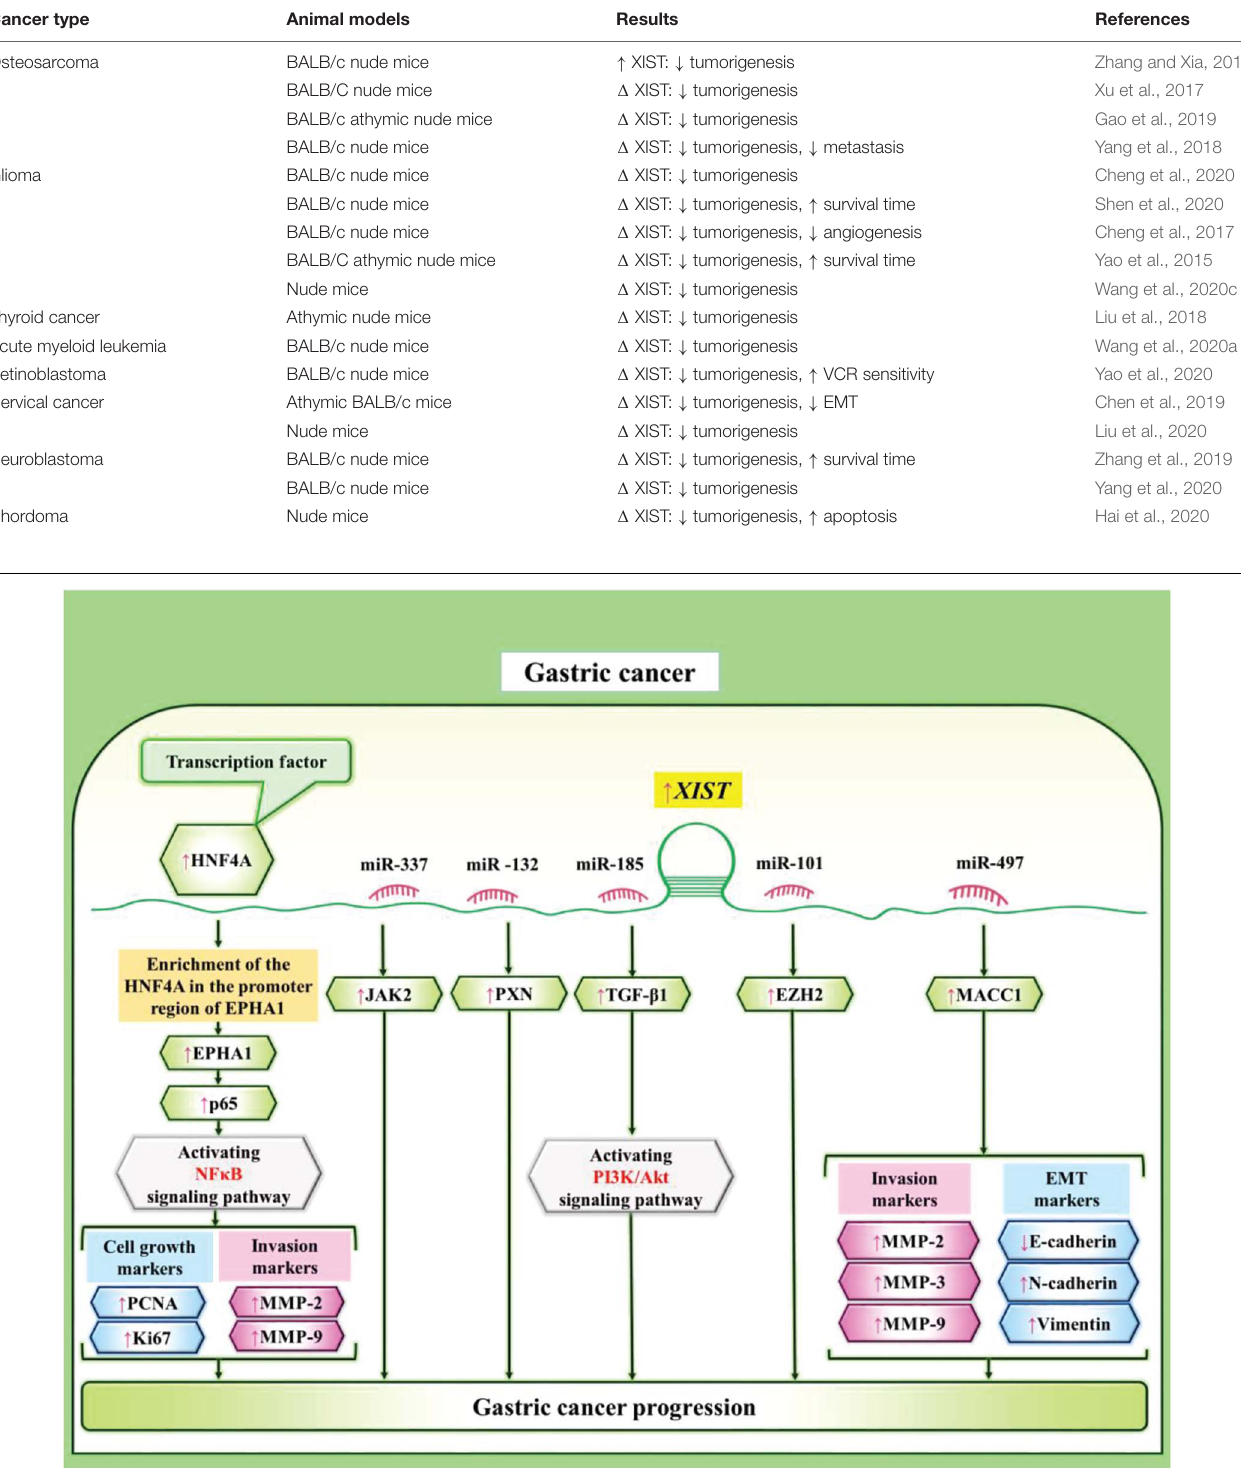
Frontiers in Cell and Developmental Biology |